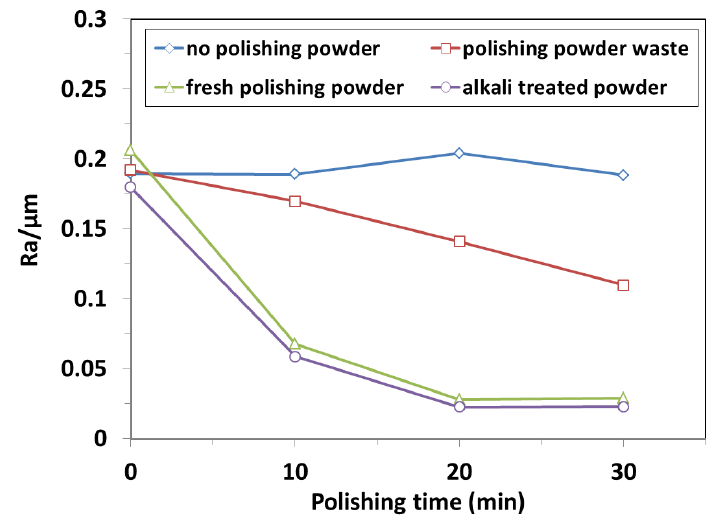
Figure 4. Effect of different polishing agents on glass polishing: the surface roughness (Ra/µm) as a function of polishing time. Adapted from Kato et al. [12], with permission from American Chemical Society, 2018.